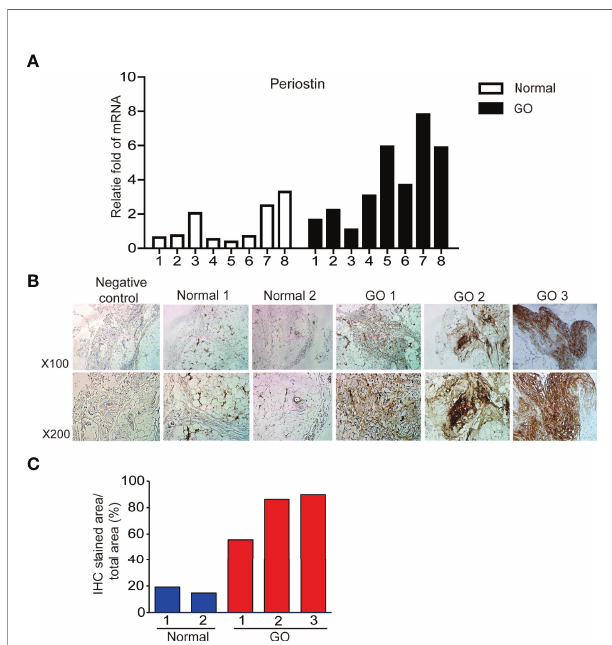
FIGURE 1 | Expression of periostin gene and protein between GO and normal tissues. Expression of POSTN gene expression (A) in GO (n=8) and normal healthy tissues (n=8) was analyzed and compared using real time PCR. Immunohistochemical staining for periostin in normal and GO tissues were carried out (B) . Stronger staining for periostin was seen in the GO tissues than in normal tissue (C)